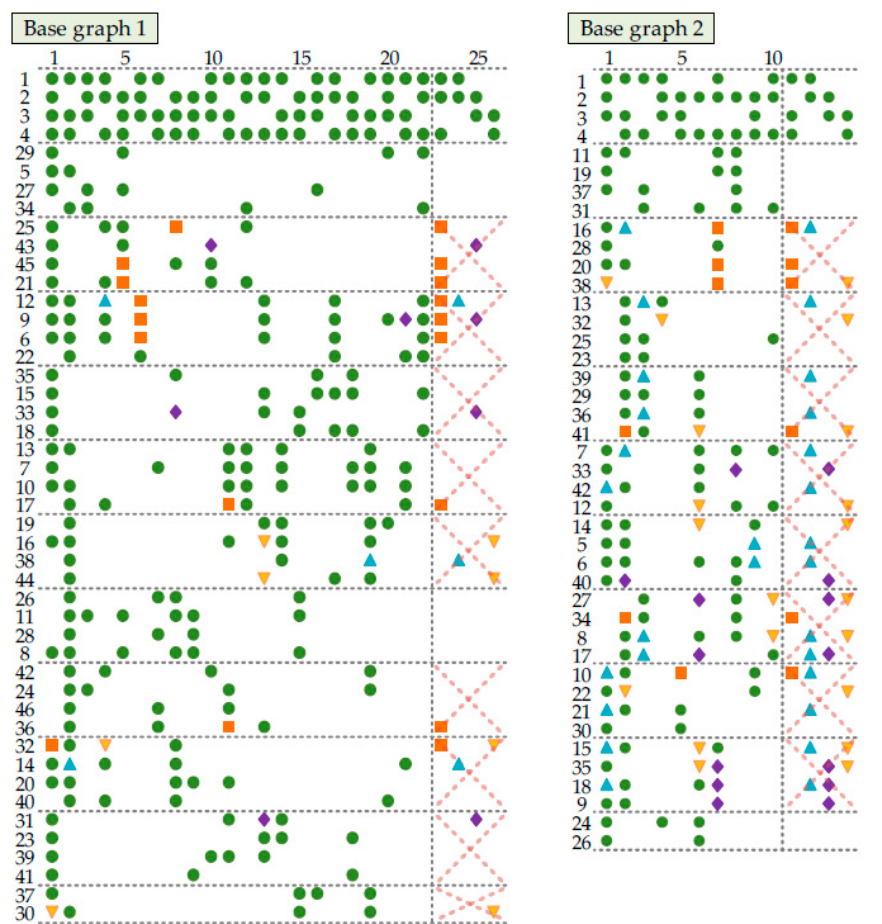
Figure 12. A scatter diagram of the optimized processing order for BG1 and BG2 codes when four CSs are available. Circles represent CPMs that are used for information bits processing, whereas other shapes represent CPMs that are used for core parity bits processing. All core parity bits processing is merged with some information bits processing when free CSs are available.